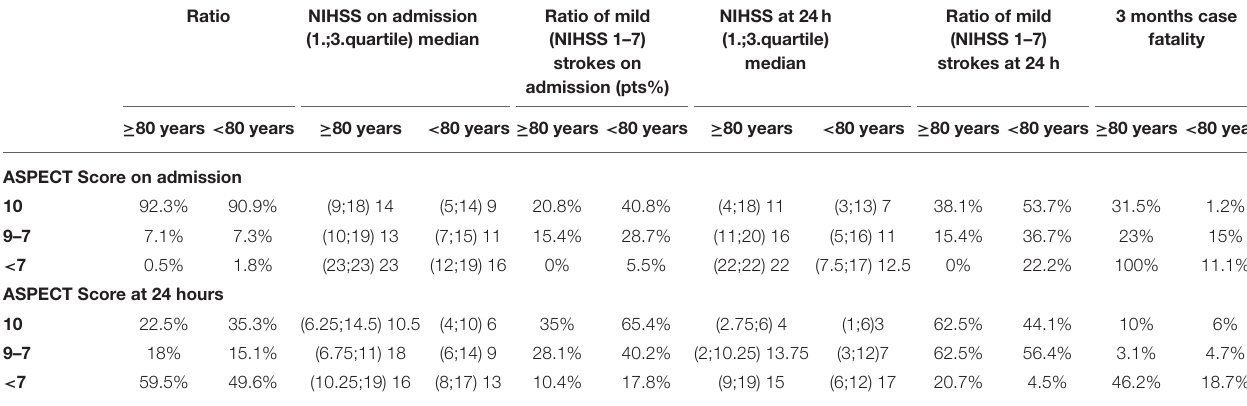
TABLE 3 | CT characteristics on admission and at 24h compared with on admission-NIHSSS, 24 h-NIHSSS and 3 months-mortality in patient groups under and above 80 years. Ratio